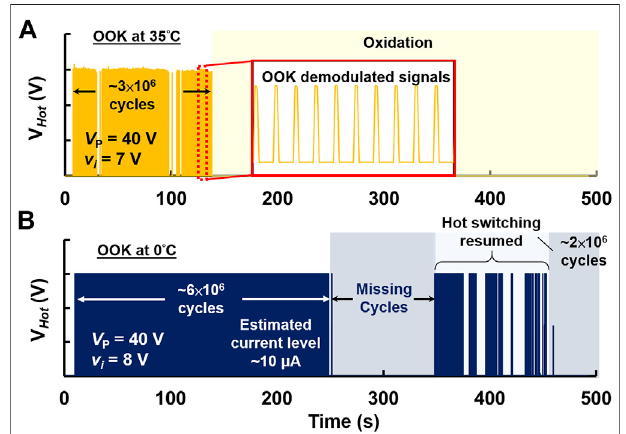
FIGURE 5 | Temperature effect on the resoswitch hot switching lifetime. Measured hot switching signal of comb-driven resoswitches operating at (A) 35 ° C and (B) 0 ° C. The results indicate that the temperature is indeed a key for determining the thermal dissipation and in turn the lifetime. Reproduced from Liao